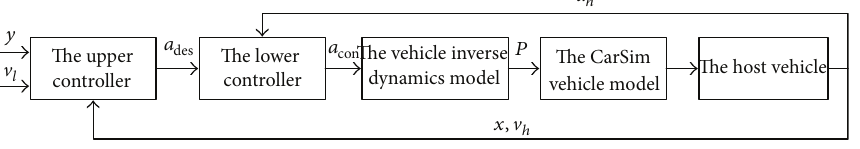
Figure 4: Scheme of the braking controller for deceleration.